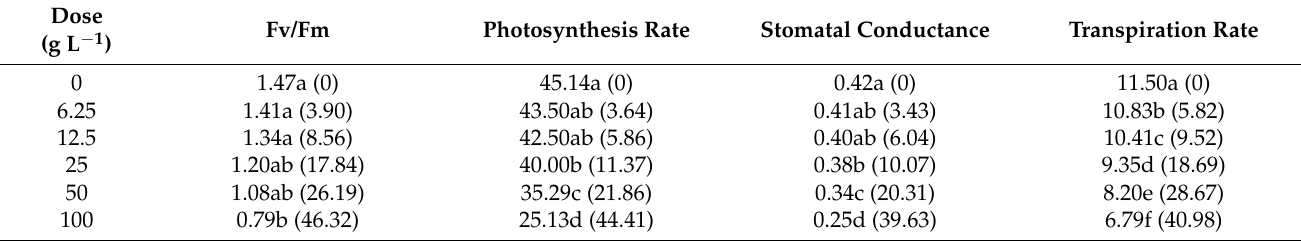
Table 3. Effects of P. hysterophorus methanol extract on Fv/Fm, photosynthesis rate ( µ mol m − 2 s − 1 ), stomatal conductance